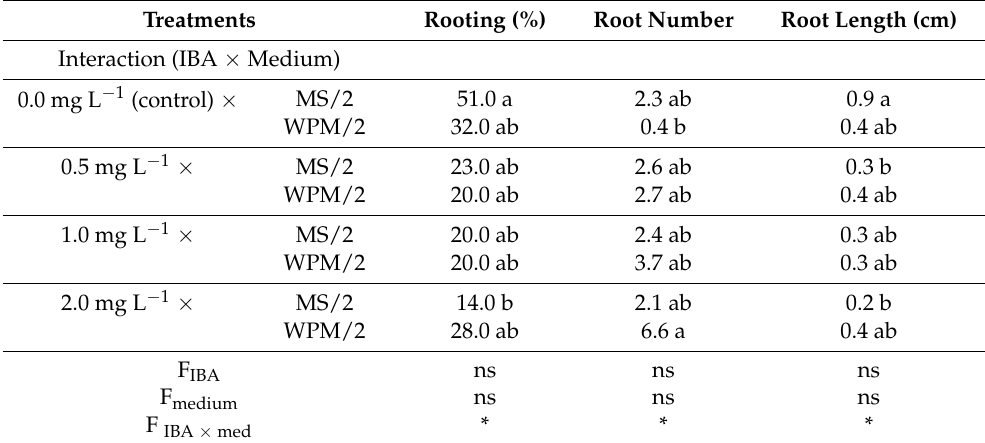
Table 6. Cont . Treatments Rooting (%) Root Number Root Length (cm) Interaction (IBA ×